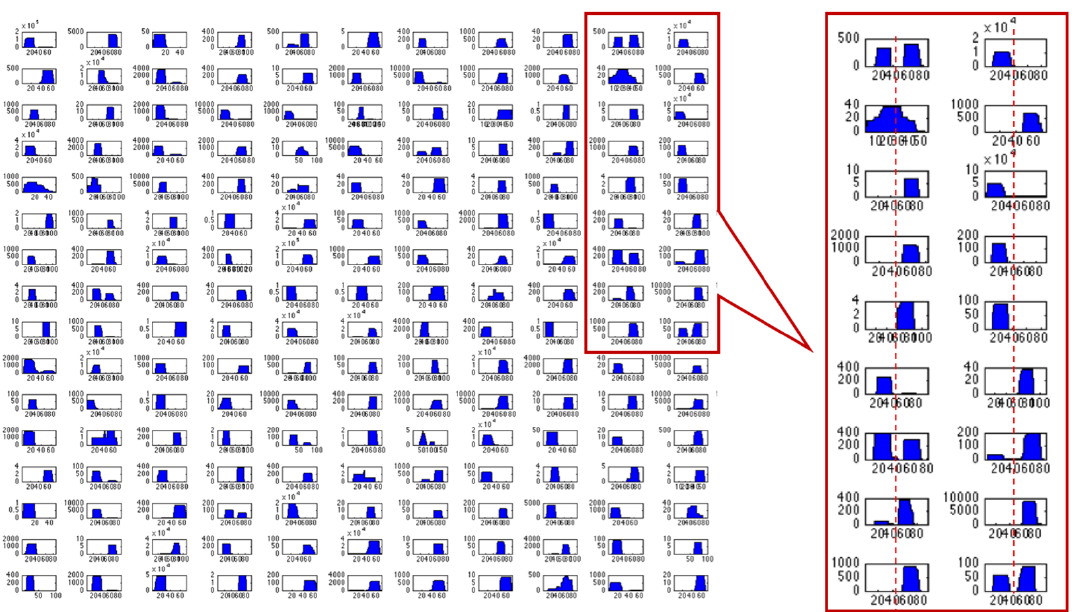
Figure 2. A collection of miRNAs expressed as reported in the miRBase database. Each panel shows the expression level of mature miRNAs by RPM (reads per million, y-axis). The active miRNA molecules are derived from the pre-miRNA, marked 0 to 80 nucleotides (x-axis). A zoom-in of a set of human miRNAs is marked by a red frame. Note: the broad range of RPM associated with individual miRNAs (y-axis).